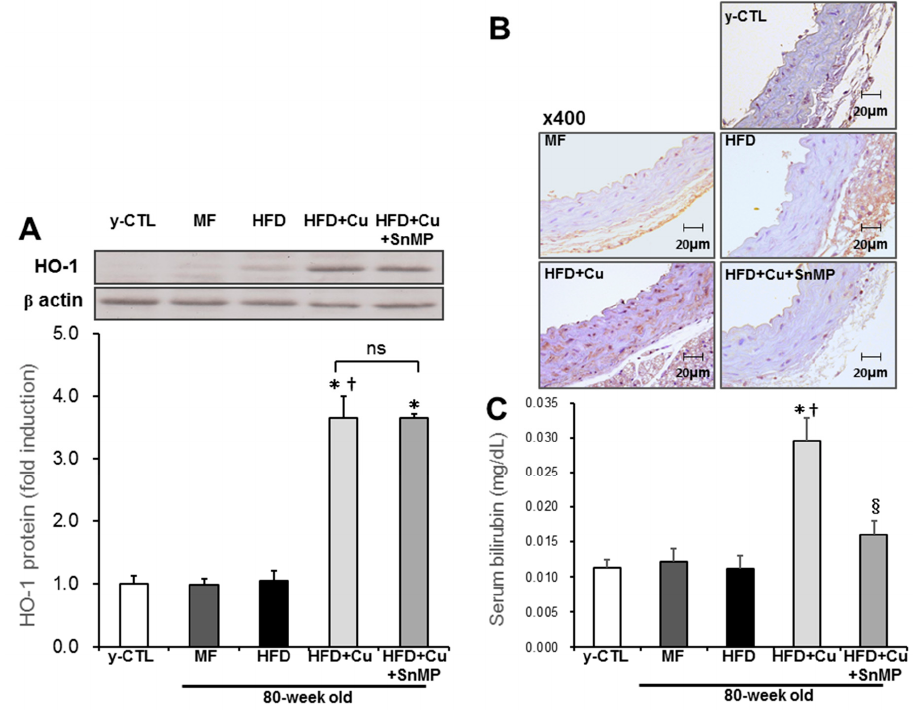
Figure 2. Effect of curcumin on HO-1 activity in mice. MF (standard feed), High-fat diet (HFD), 0.1% curcumin-mixed HFD (HFD + Cu), or 0.1% curcumin-mixed HFD plus SnMP (HFD + Cu + SnMP) was fed to mice for 72 weeks. ( A ) HO-1 expression in the aorta was assessed by Western blotting. The expression level was standardized by β -actin. ( B ) Bilirubin expression in the thoracic aorta was assessed by immunohistochemistry. ( C ) Blood bilirubin concentration was measured by a bilirubin assay kit. Data were presented in mean ± standard error for each group ( n = 5). * P < 0.05 vs y-CTL, † P < 0.05 vs HFD, § P < 0.05 vs. HFD + Cu. SnMP, Stannous Mesoporphyrin; HO-1, Heme Oxygenase- 1; y-CTL, 8 weeks old mice.